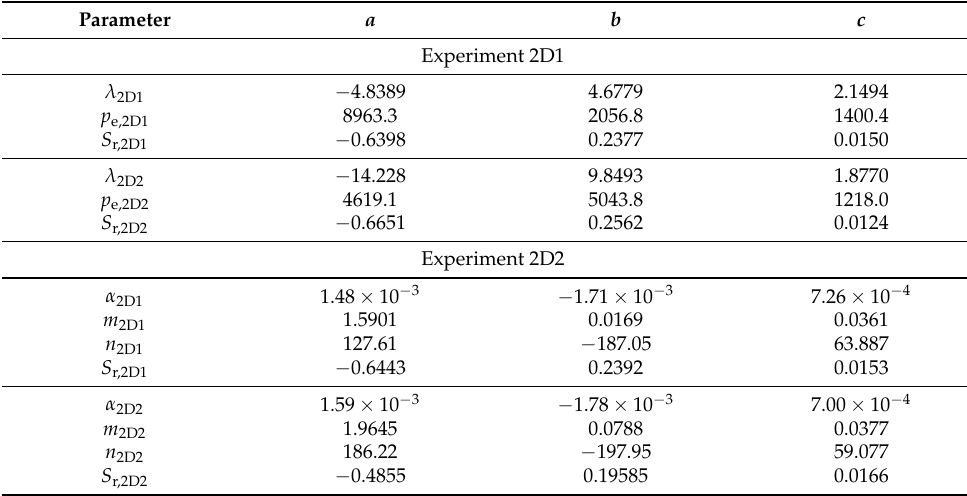
Table 3. Parameters of the second-order polynomial expression describing the effect of porosity reduction due to EICP on the capillary pressure–saturation relations, see Equation